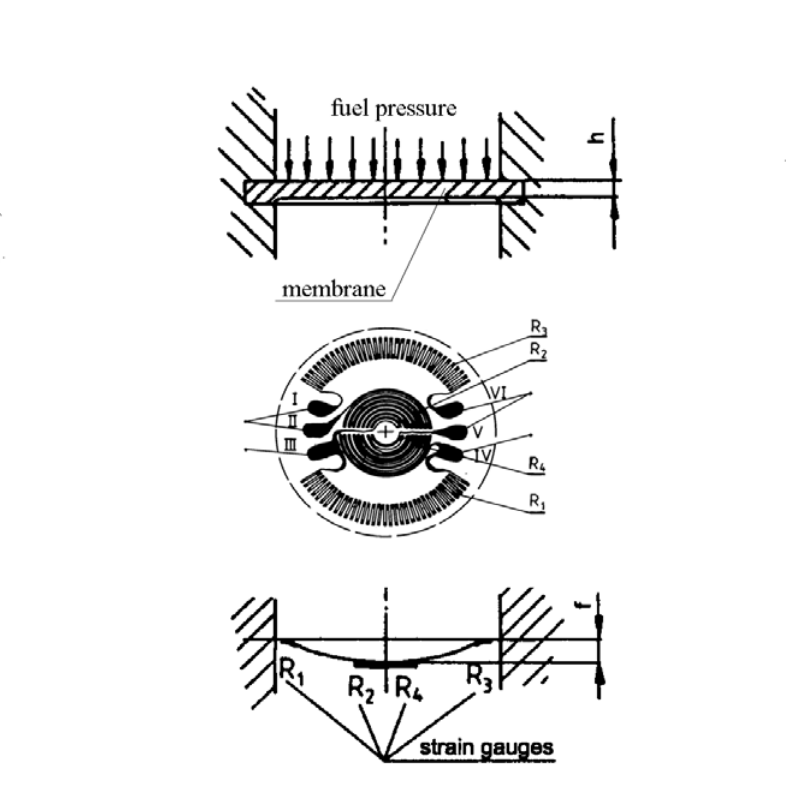
Figure 4. Tension strain exerted upon membrane and position of strain